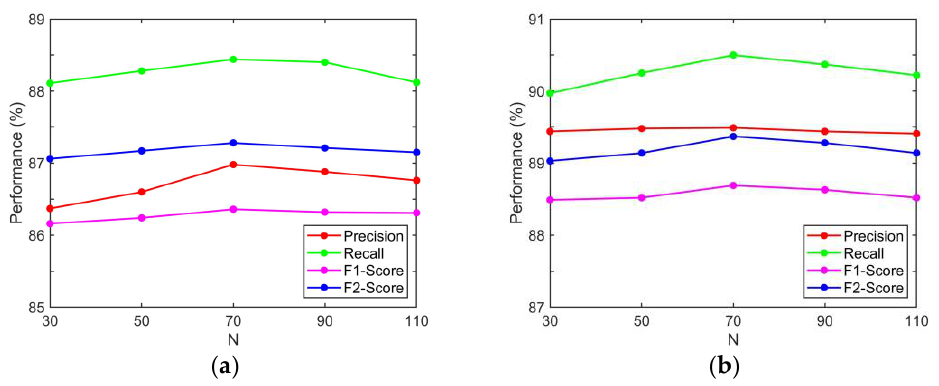
Figure 6. Performance comparisons with a different number of superpixel regions: ( a ) Performances on the UCM multi-label dataset; ( b ) Performances on the AID multi-label dataset.